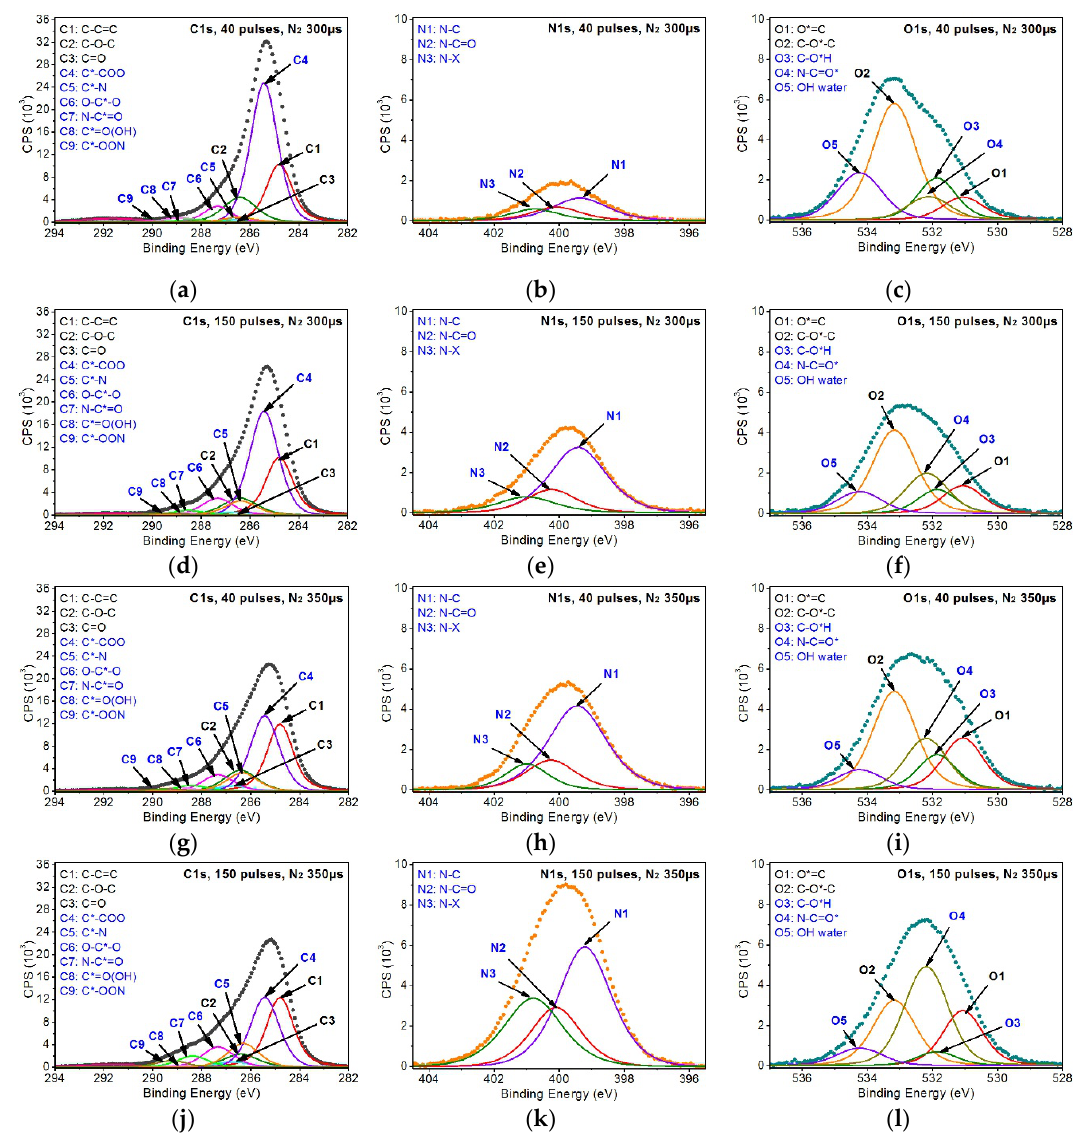
Figure 8. XPS spectra of modified PEEK: ( a ) C1s band for 40 pulses (N 2 300 µs), ( b ) N1s band for